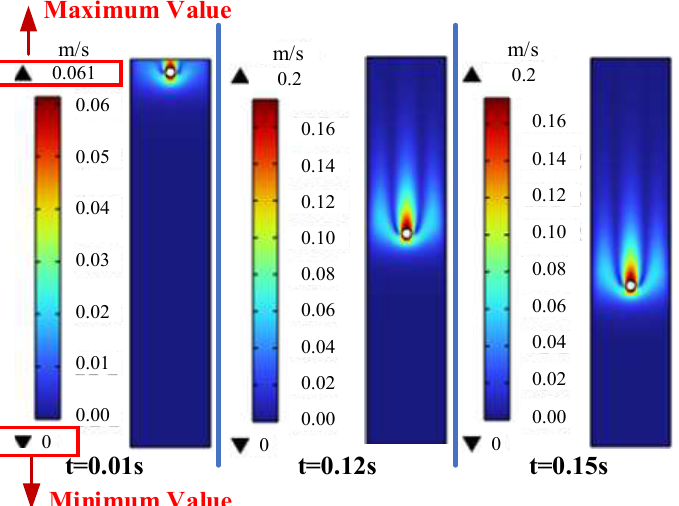
Figure 8. Velocities of a copper particle with a diameter of 1 mm in the pipeline at different times.